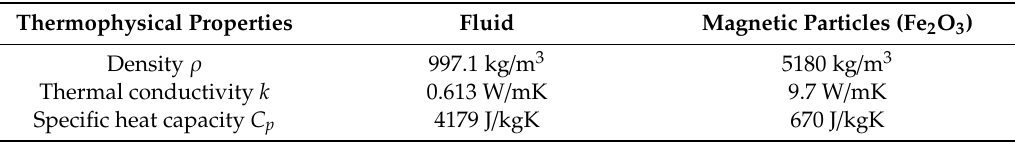
Table 1. Thermophysical properties of the fluid and the magnetic